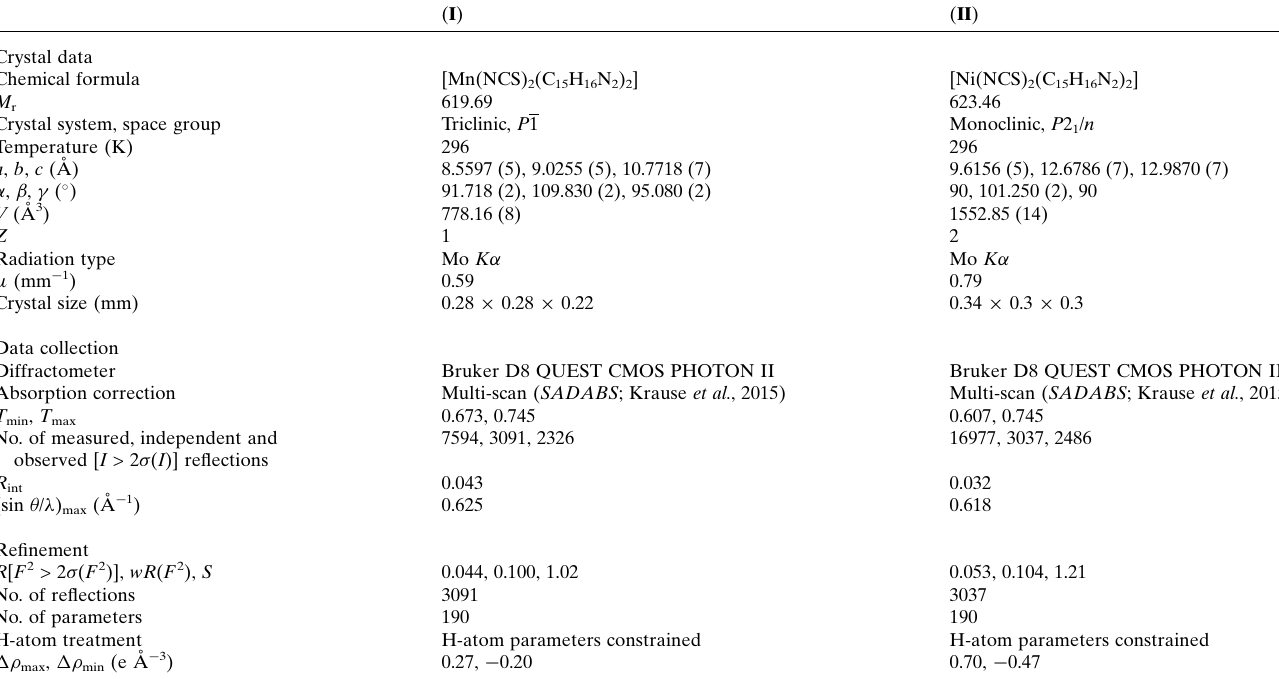
Table 3 Experimental details.